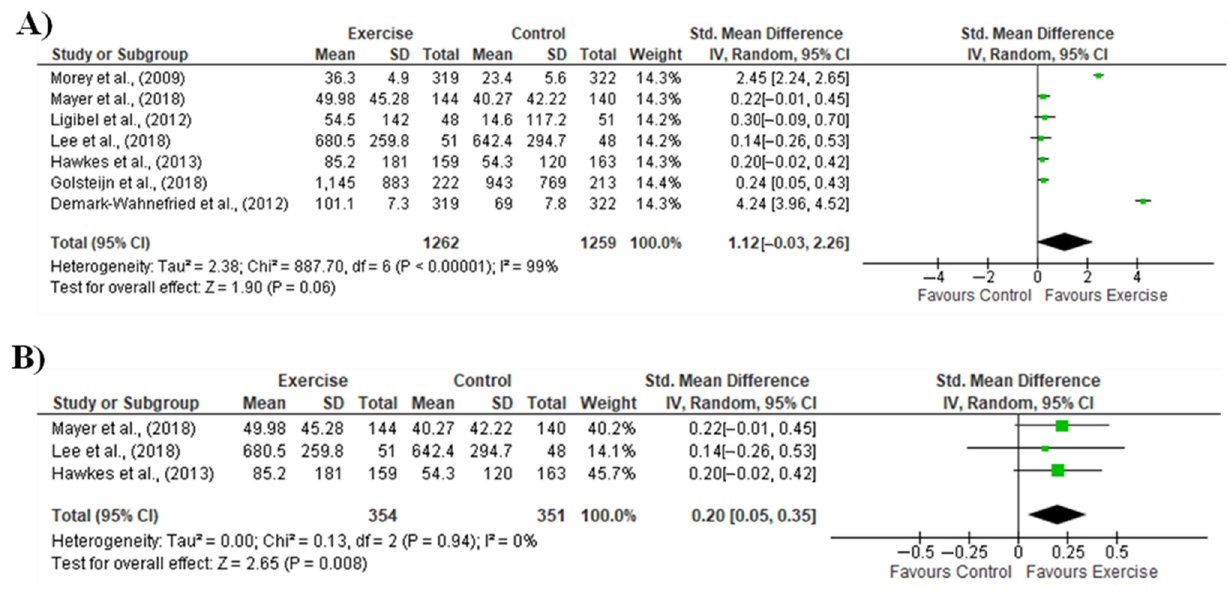
Figure 2. Meta-analysis of physical activity (dependent variable) measured in randomized controlled trials that conducted remote and unsupervised exercise for cancer patients; ( A ) Comparison of the physical activity levels between cancer patients—including colorectal—submitted to remote and unsupervised exercise and cancer patients in the control group; ( B ) Sensitivity analysis considering the studies that only included patients diagnosed with colorectal cancer [28–34].